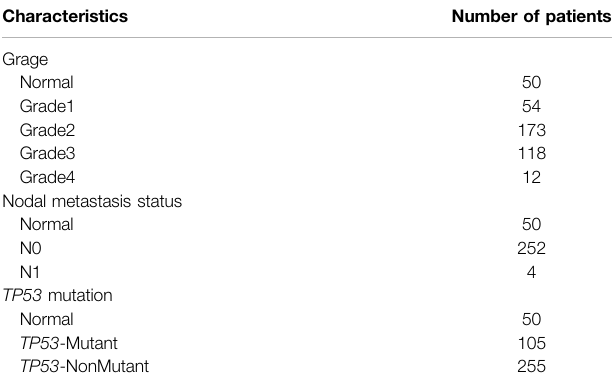
TABLE 1 | Clinical characteristics of TCGA LIHC patients included in this